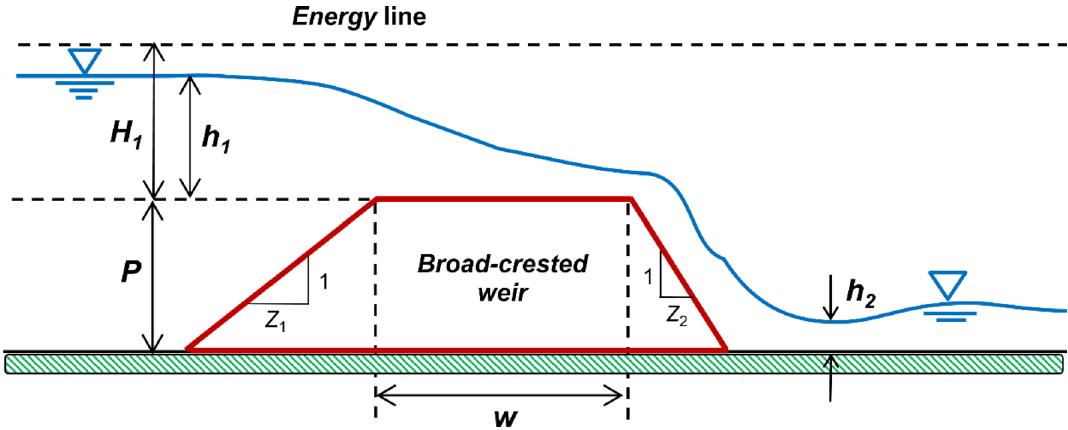
Fig. 1 Geometrical and hydraulic parameters of the broad-crested weir Table 1 Geometrical properties of broad-crested weirs in this study Weir